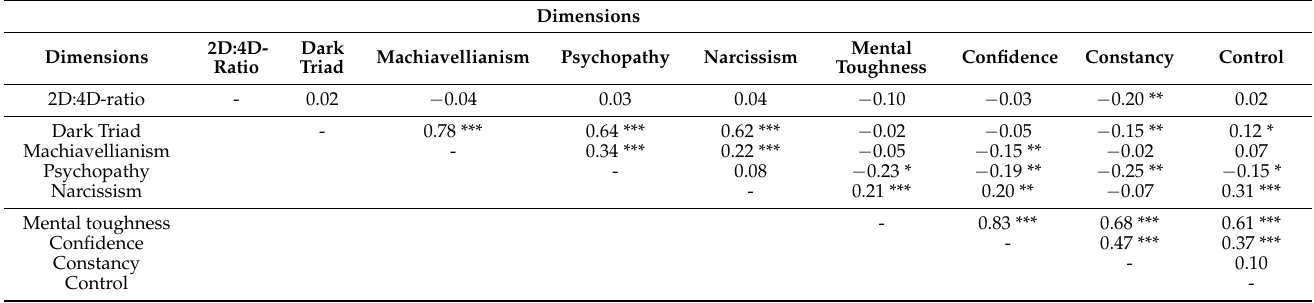
Table 2. Correlational associations (Pearson’s coefficients) between 2D:4D-ratio, mental toughness, and dark triad traits among female participants ( n = 308).